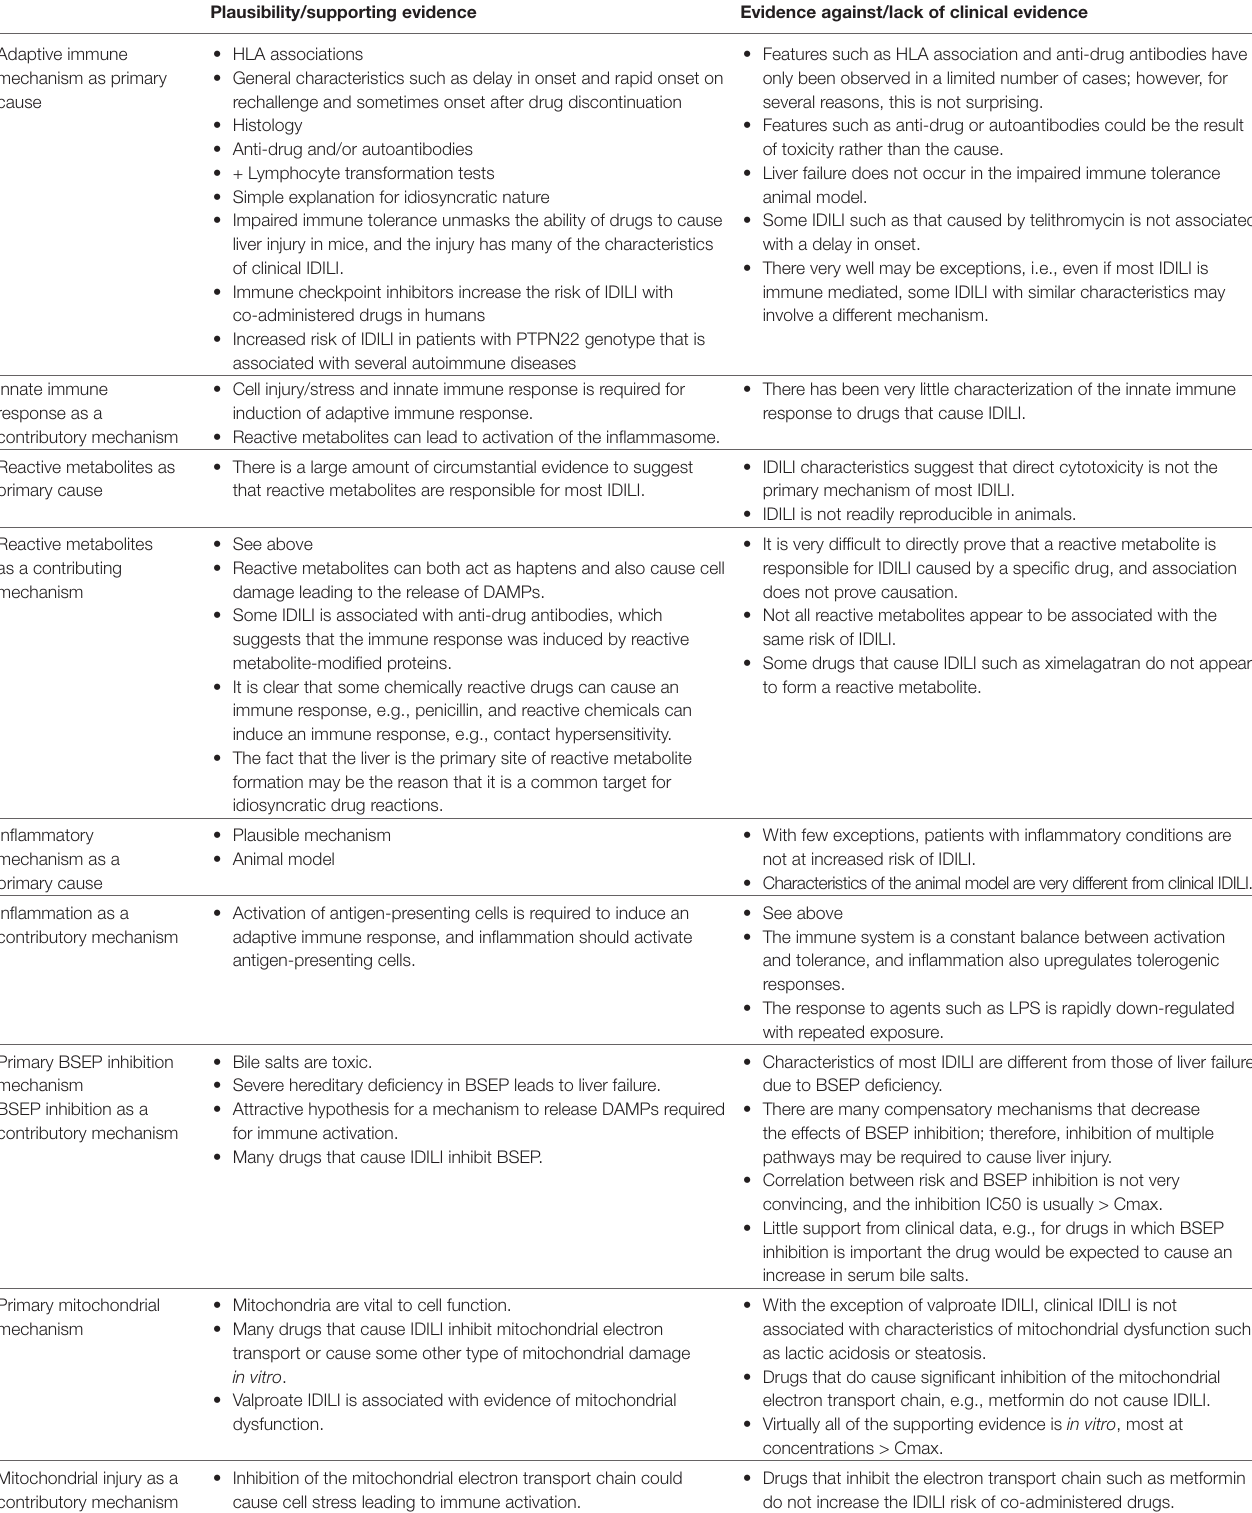
TABLE 1 | Summary of the major hypotheses for the mechanism of idiosyncratic drug-induced liver injury